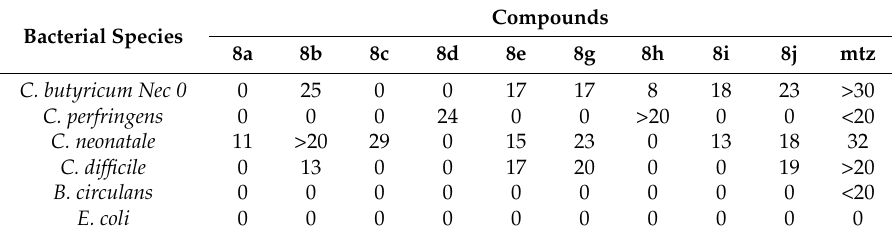
Table 8. Antibacterial activity of molecules 8a – j obtained with the one-pot Suzuki-Miyaura/ Sonogashira